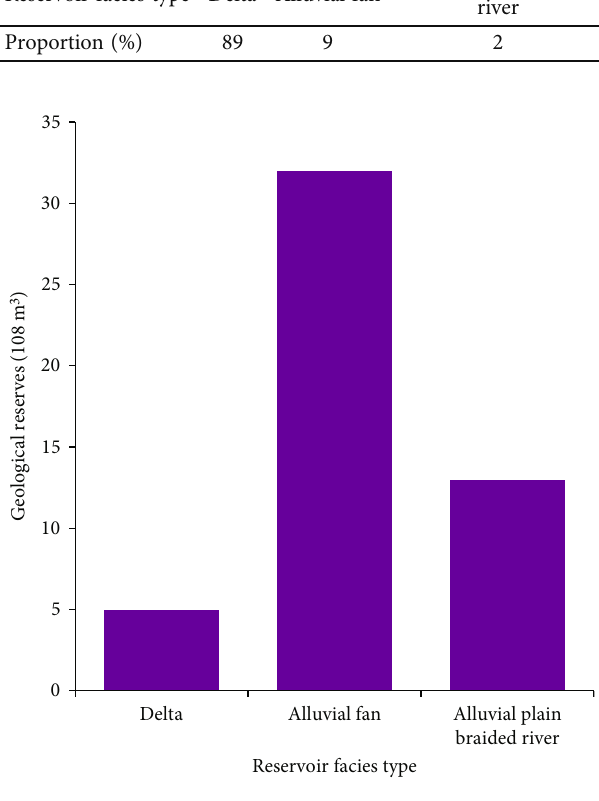
Figure 4: Geological reserves of natural gas at di ff erent reservoir- source distances in Upper